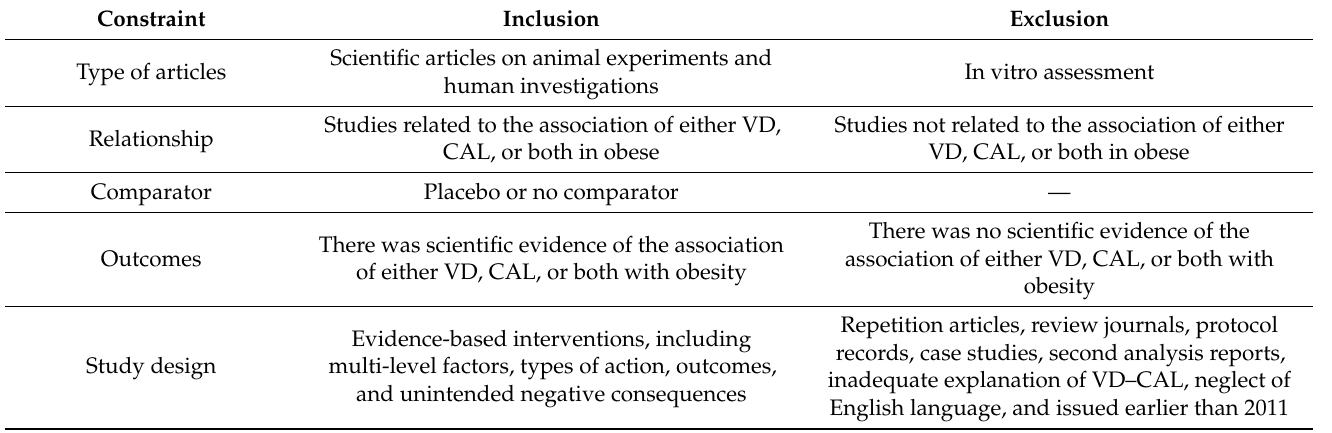
Table 1. Search constraints and criteria.